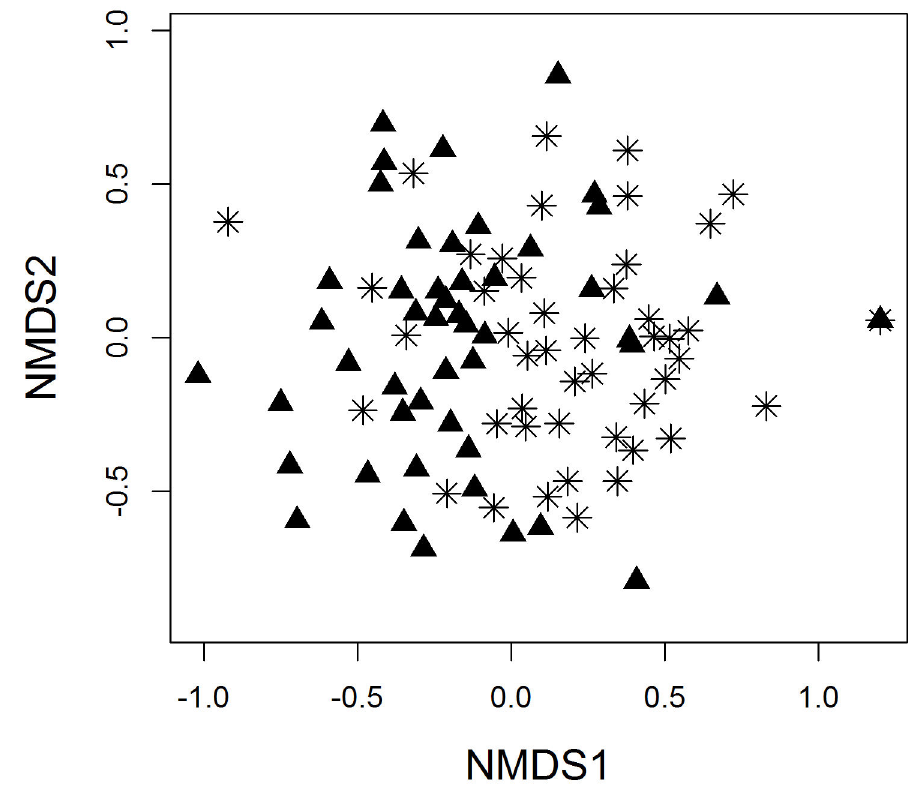
Figure 2. Non-metric multidimensional scaling (NMDS) ordination of the bird assemblages in primary forests (solid triangles) and windbreaks (asterisk). Points are census sites. The ordination diagram is for visualisation only; all tests of treatment effects are conducted using mvabund (see text for statistical